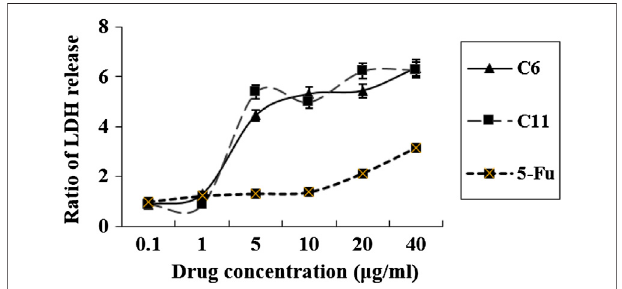
FIGURE 8 | Cellular necrosis was measured as LDH release after treatment for 24 h with the drugs.